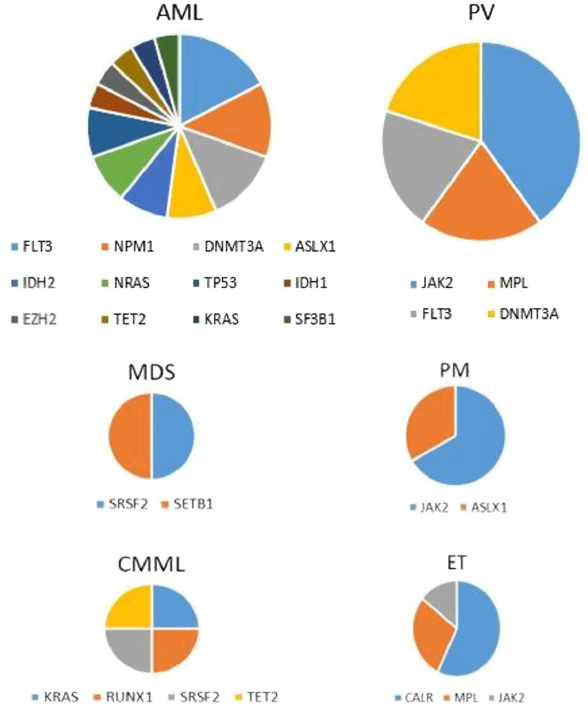
Figure 1. Mutations determined by NGS myeloid panel test according to the diagnosis. AML, acute myeloid leukemia; ET, essential thrombocytosis; PV, polistemia vera; PM, primary myelofibrosis; MDS, myelodysplastic syndrome; CMML, chronic myelomonocytic